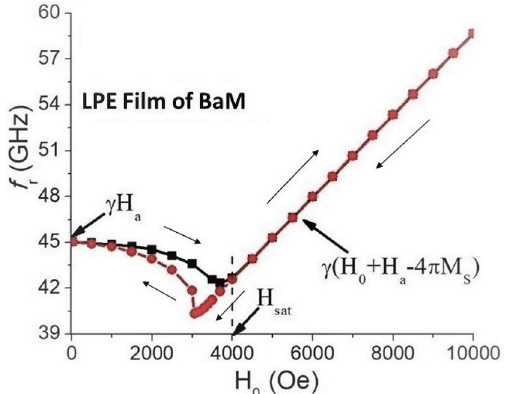
Figure 2. The resonance frequency f r as a function of bias magnetic field H o for the FMR in LPE thin-film barium hexaferrite sample.